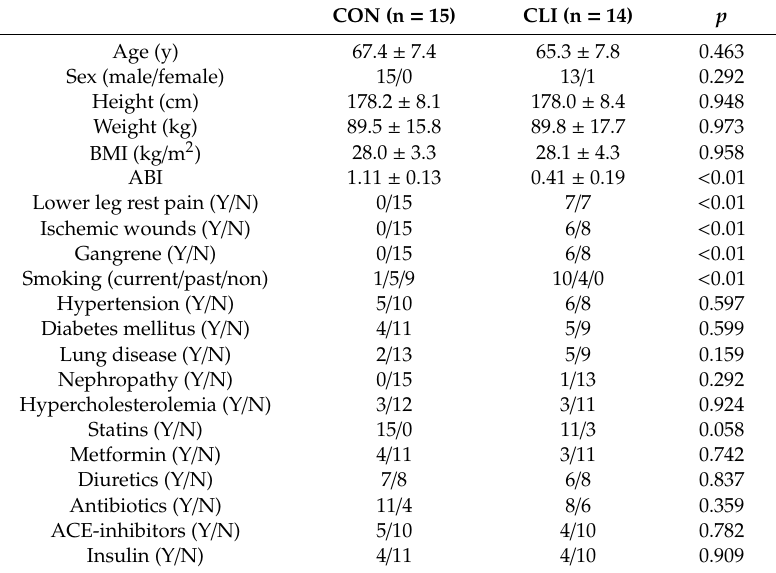
Table 1. Anthropometric and clinical characteristics.